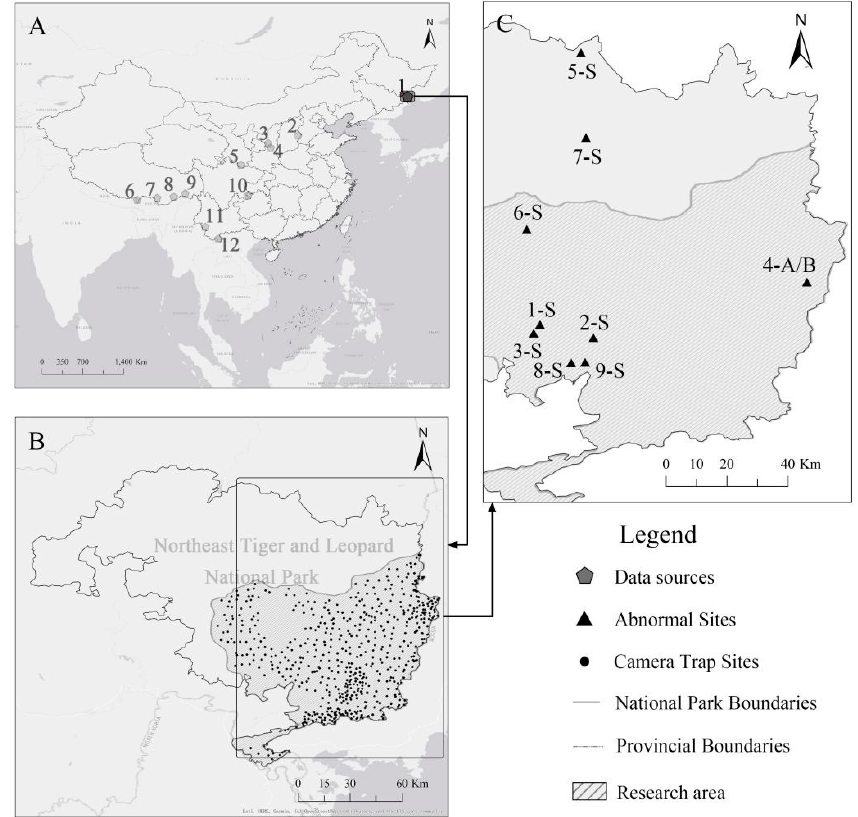
Figure 1. ( A ) Areas with positive results for yellow-throated marten observations. 1: Northeast Tiger and Leopard National Park; 2: Jinzhong; 3: Ziwuling; 4: Qiaoshan; 5: Giant Panda National Park; 6: Yadong; 7: Cona; 8: Medog; 9: Zayu; 10: Xishui; 11: Nangunhe; and 12: Xishuangbanna. ( B ) Distribution of all 597 working cameras, from 1 January 2014 to 31 December 2015. ( C ) Locations where 18 abnormally-colored (except ‘gloving’) records were obtained in Northeast Tiger and Leopard National Park.